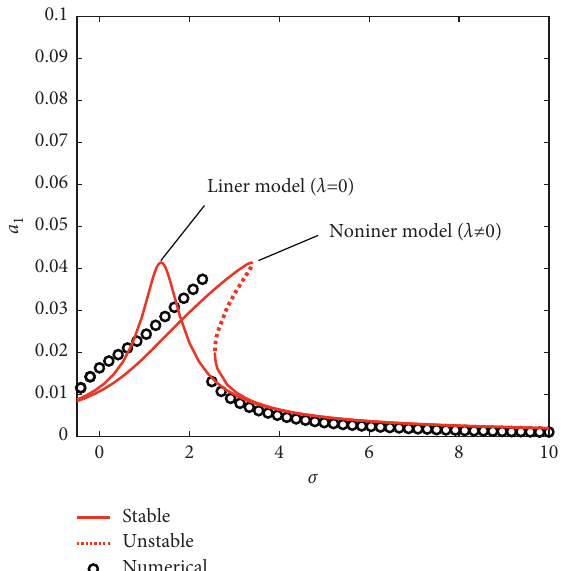
Figure 40: Comparison of results between the method of multiple scales and the numerical simulation (case I, L/d � 10, c � 0.03, θ � 0 ° , Ω � 50, K f �